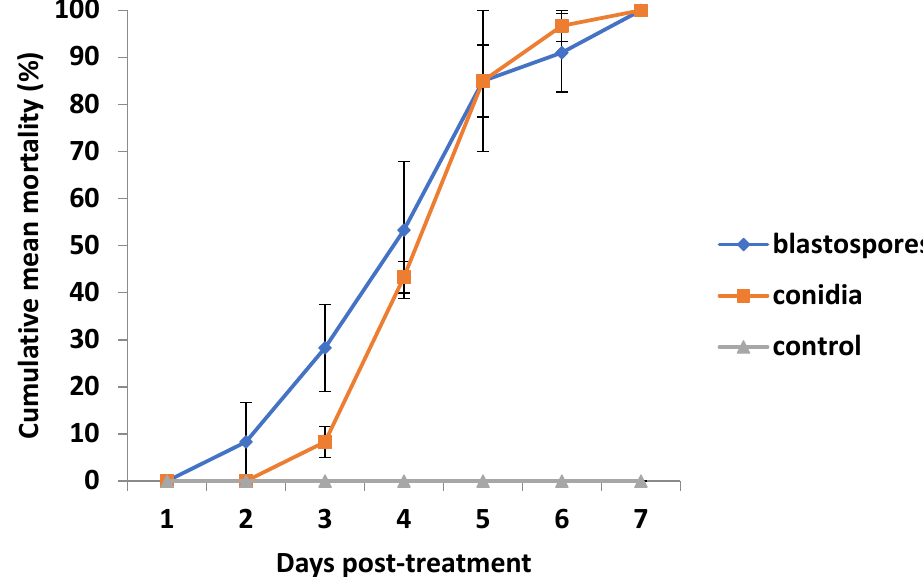
Figure 2. Mortality of Diaphorina citri adults after feeding on a leaf disk sprayed with blastospores, conidia of Cja Apopka or Tween 80 (control) over time.